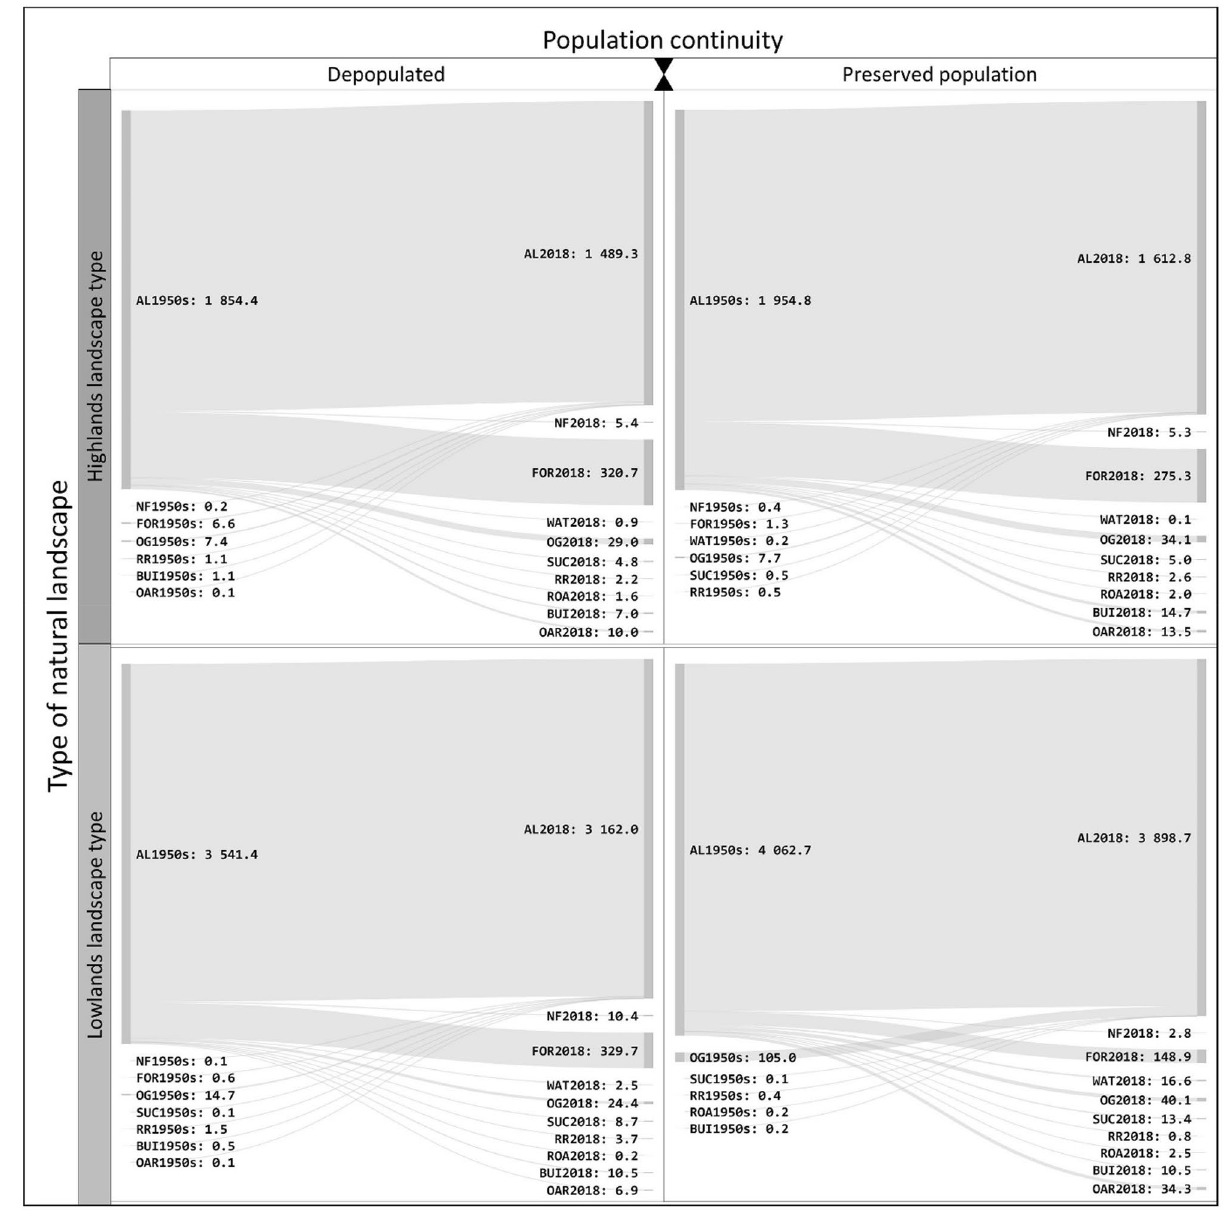
Figure 3. Agricultural land change trajectories between 1953 and the most recent time horizon in depopulated areas and in areas with preserved population considering their location in different landscape types (in